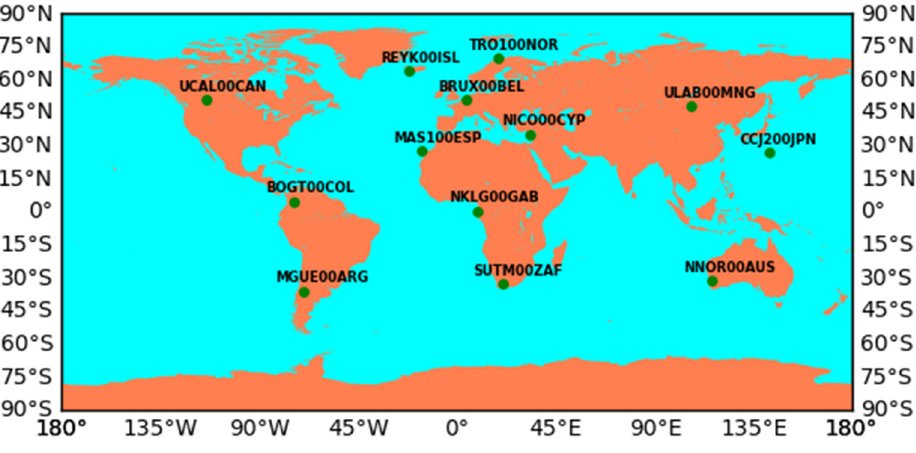
Figure 1. Location of test stations. Table 1. Methods and models used.